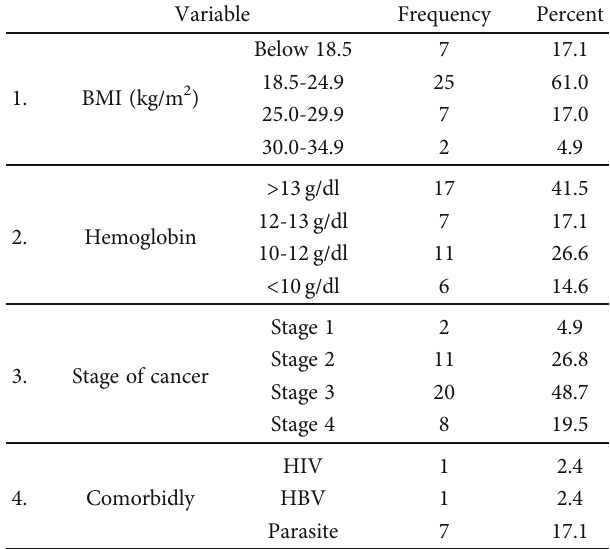
Table 3: Clinical characteristics of study participants during stool sample collection.